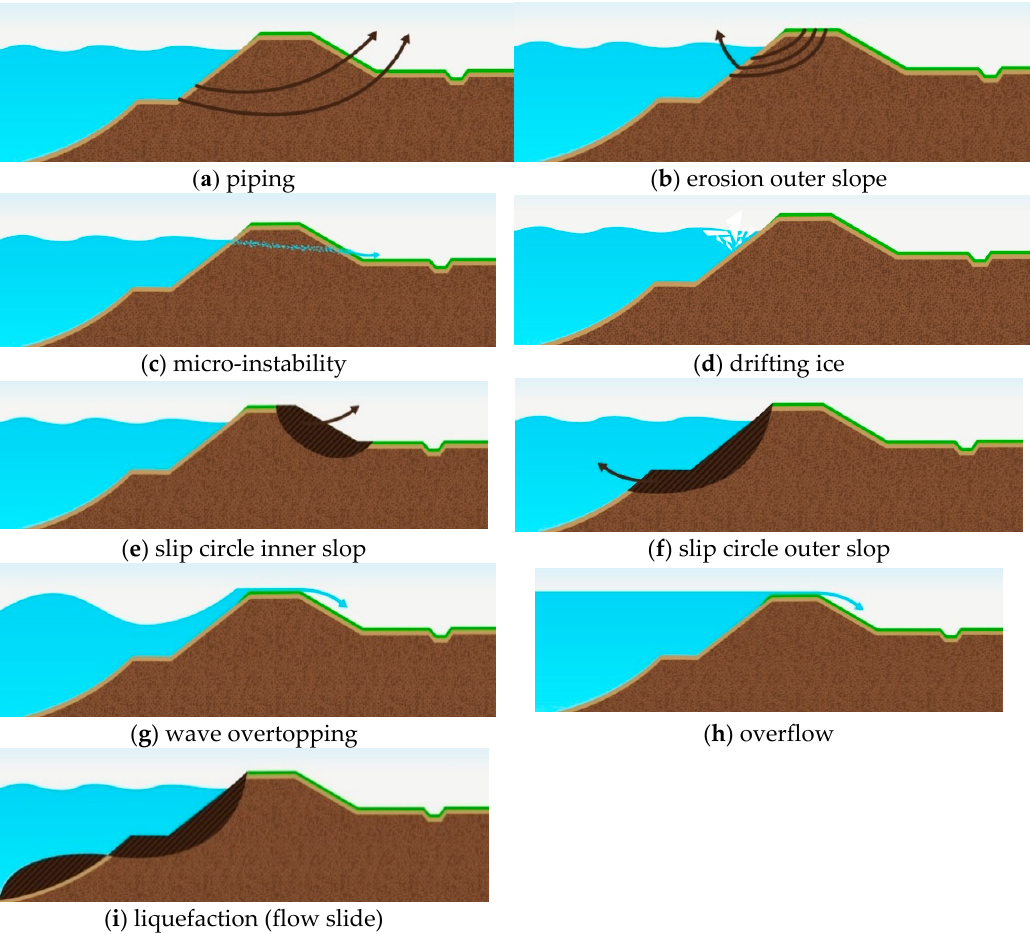
Figure 5. Examples of flood embankment failure types.